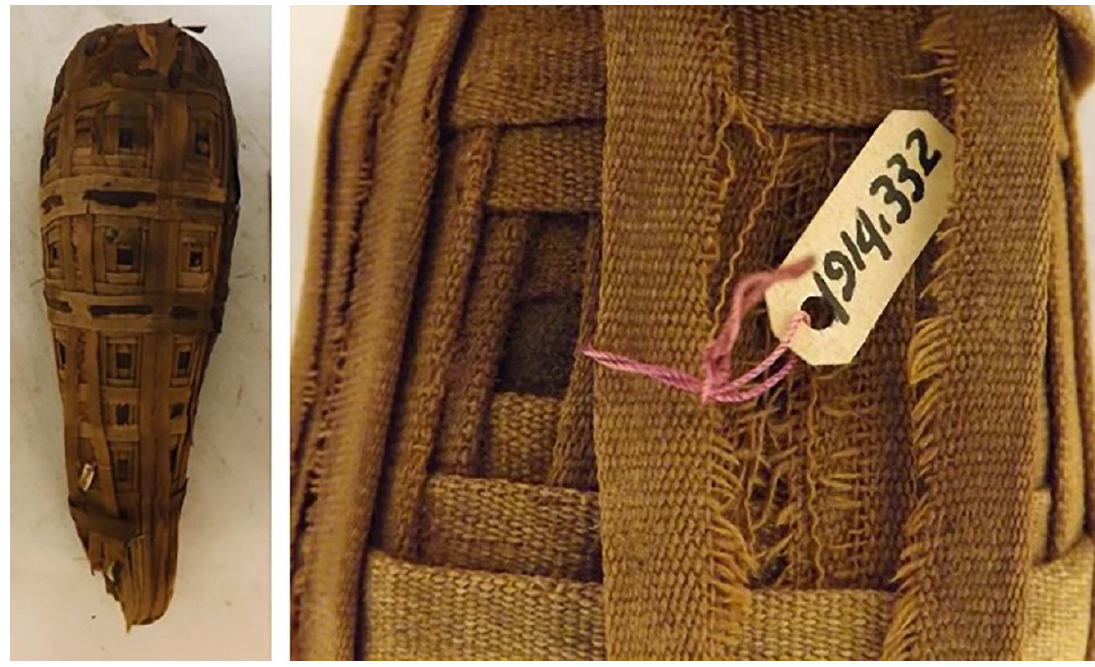
Figure 2. Photograph of ibis mummy MFA acc. no. 6255 with close up showing the original excavation label from the 1914 season. [Photographs taken by author.].